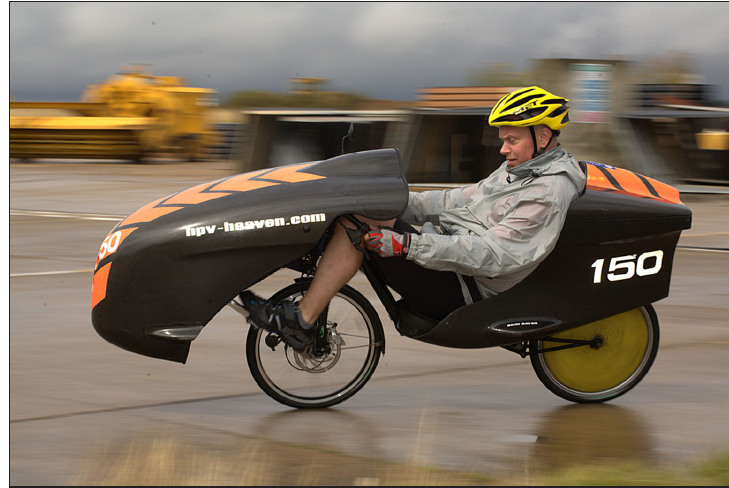
Figure 2: Recumbent cycle with front and rear